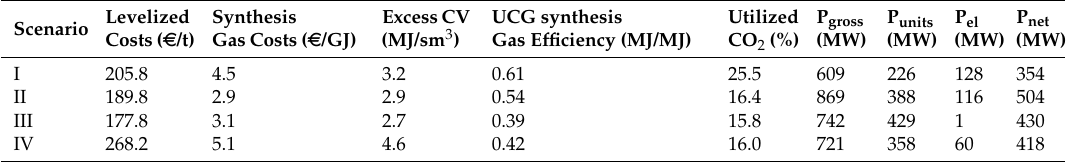
Table 20. One-at-a-time sensitivity analysis results for the onshore UCG-MeOH-CCU scenario considering different synthesis gas compositions and calorific